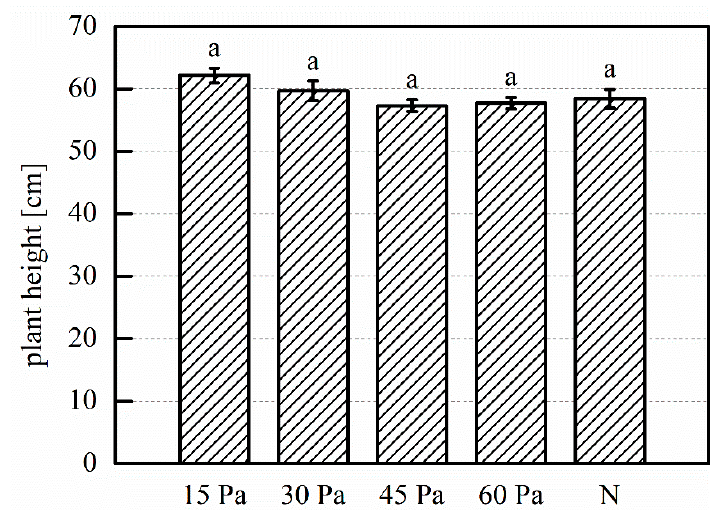
Figure 9. Mean plant height at harvest of garlic plants grown from treated and untreated cloves. 15 Pa, 30 Pa, 45 Pa, 60 Pa: plasma treatments at the indicated working pressure; N: untreated control. Number of replications: n = 3 (of five samples each, total 15 samples). Error bars indicate standard error. Different letter labels indicate statistically significant differences ( p < 0.05).